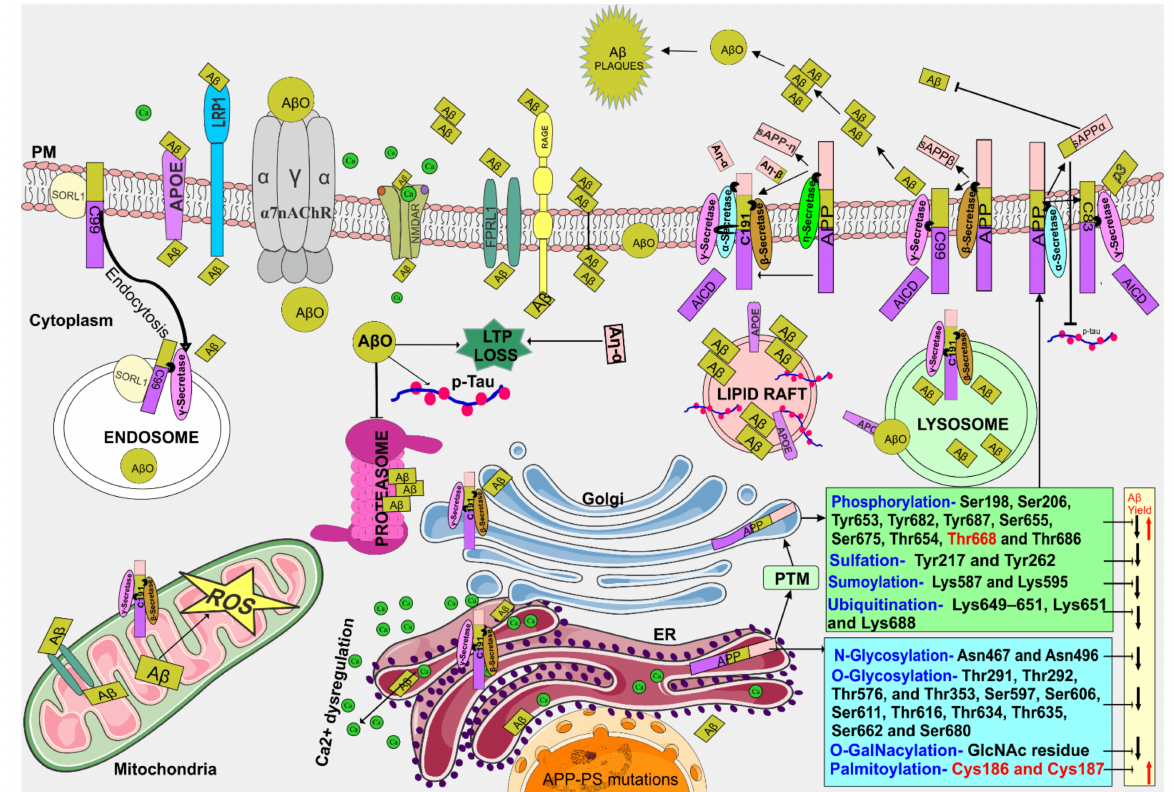
Figure 1. APP processing and A β generation: The PTM of APP alters A β production. The APP processing by the secretases ( α , γ , β and η ) at plasma membrane (PM), mitochondria, ER, lysosome, GC and lipid rafts generate its metabolites notably A β . A β undergoes oligomerization and plague formation at extra cellular matrix (ECM) and the ECM A β enters the cytoplasm through direct PM passing and receptor mediated internalization. Intra cellular A β accumulation in the cell organelle impairs its physiological